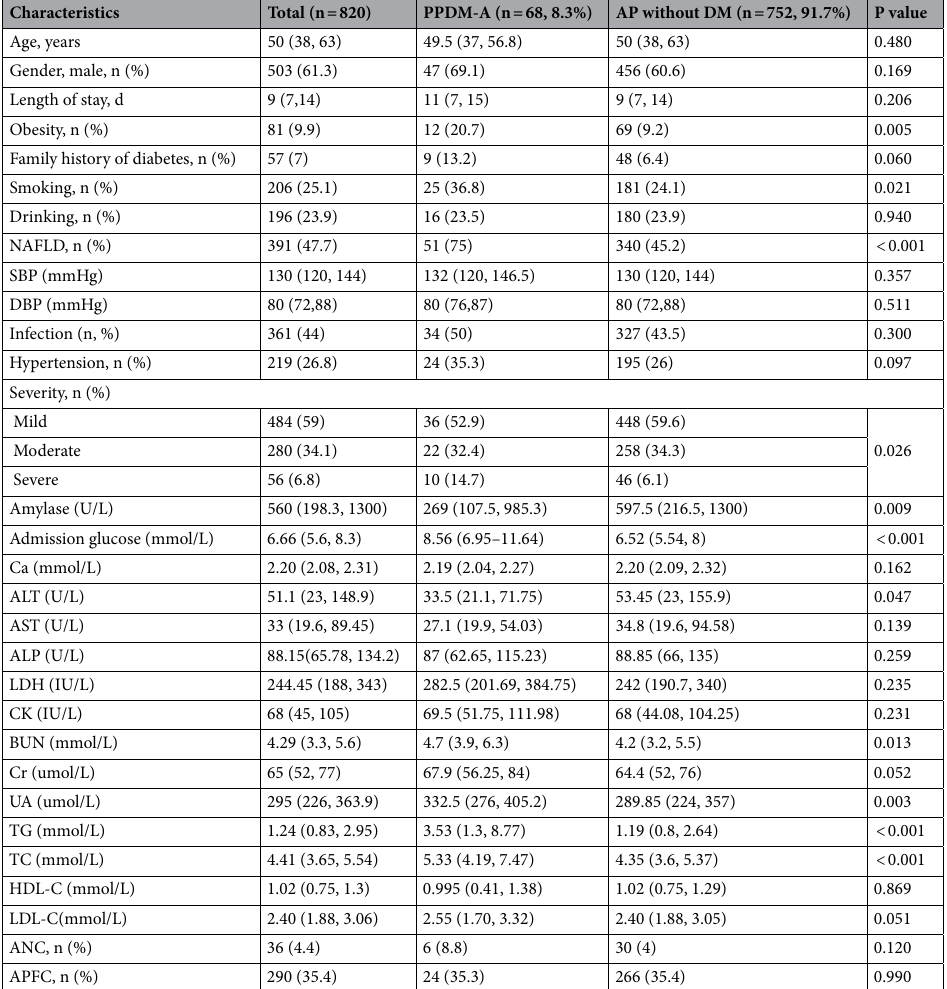
Table 1. Patient demographics and clinical characteristics. Values are given as median (IQR) or frequencies (percentages). SBP systolic blood pressure, DBP diastolic blood pressure, ALT alanine transaminase, AST aspartate aminotransferase, ALP alkaline phosphatase, LDH lactate dehydrogenase, NAFLD non-alcoholic fatty liver disease, Cr creatinine, BUN blood urea nitrogen, UA uric acid, TG triglyceride, TC total cholesterol, HDL- C high-density lipoprotein cholesterol, LDL-C low-density lipoprotein cholesterol, APFC acute peripancreatic fluid collection, ANC acute necrotic